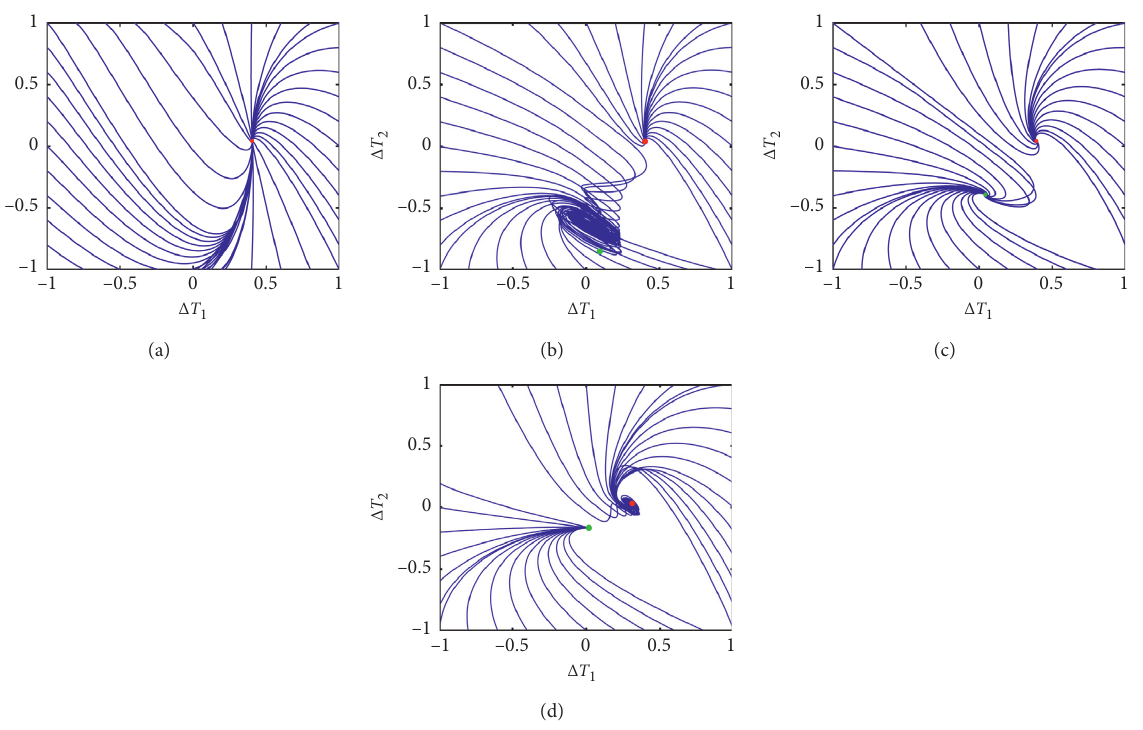
Figure 10: Phase portraits for different height ratios as k �− 0.9. (a) α � 0.05. (b) α � 0.2. (c) α � 1. (d) α � 12.